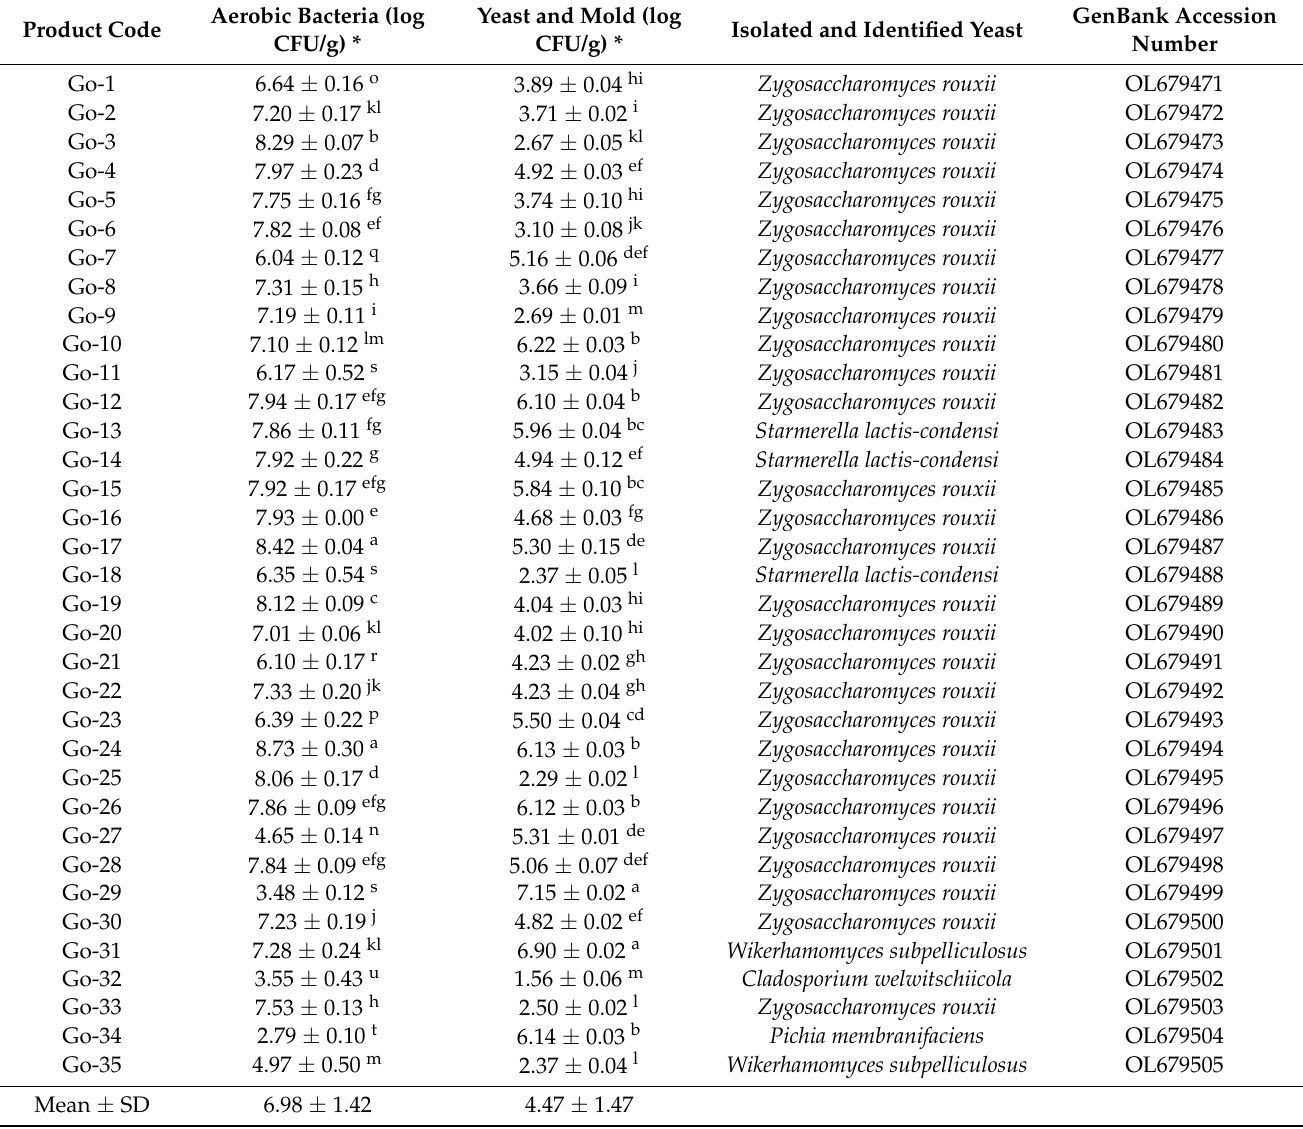
Table 2. Microbial profile of the gochujang